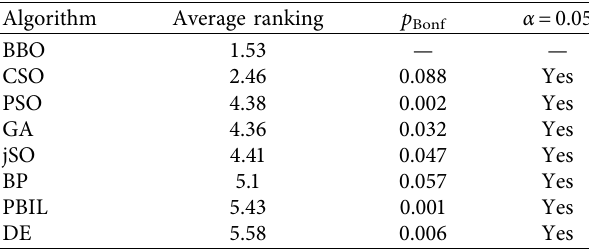
Table 9: Overall statistical comparison obtained by Friedman test of seven learning algorithms for four datasets. Algorithm Average